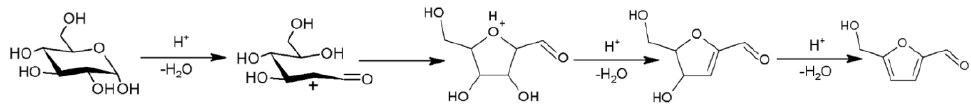
Figure 3. Mechanism of direct HMF synthesis from glucose, catalyzed by Brønsted acid.